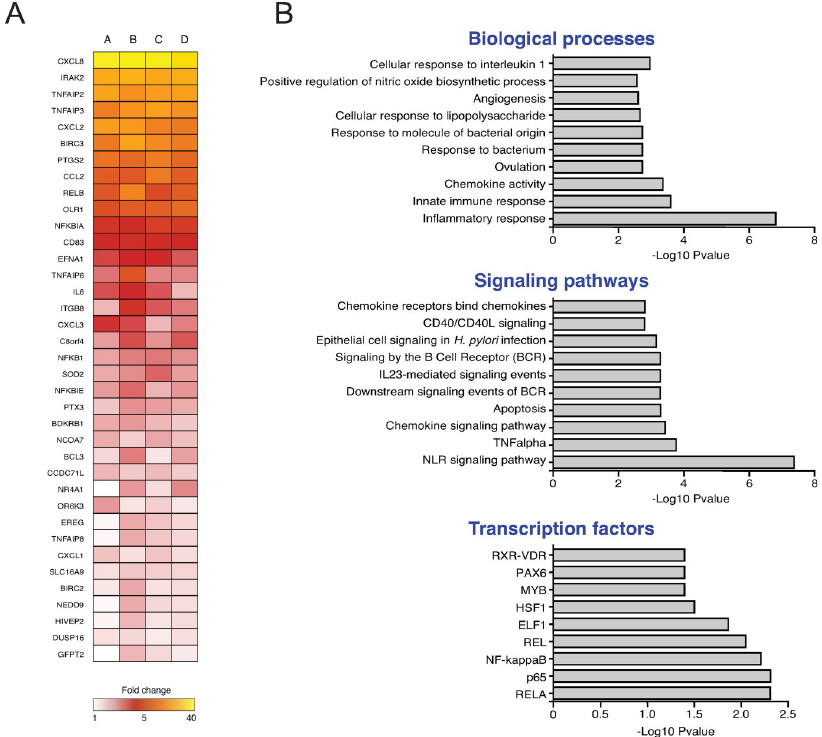
Fig 6. C . jejuni ADP-heptose and/or heptose metabolites activate a wide set of pro-inflammatory genes. (A) Selection of the highest upregulated genes revealed by microarray analysis of HeLa 57A cells stimulated for 2 h with sterile C . jejuni conditioned culture medium. Depicted are four independent repeats (A-D) shown as fold change over mock-stimulated conditions. (B) Analysis of the microarray data set by InnateDB on Biological process, signaling pathway or transcription factors.–LOG10 p-values represent the significance of over-representation of a process, pathway, transcription factor in the microarray data set (fold change > 2 and a p-value < 0.05).